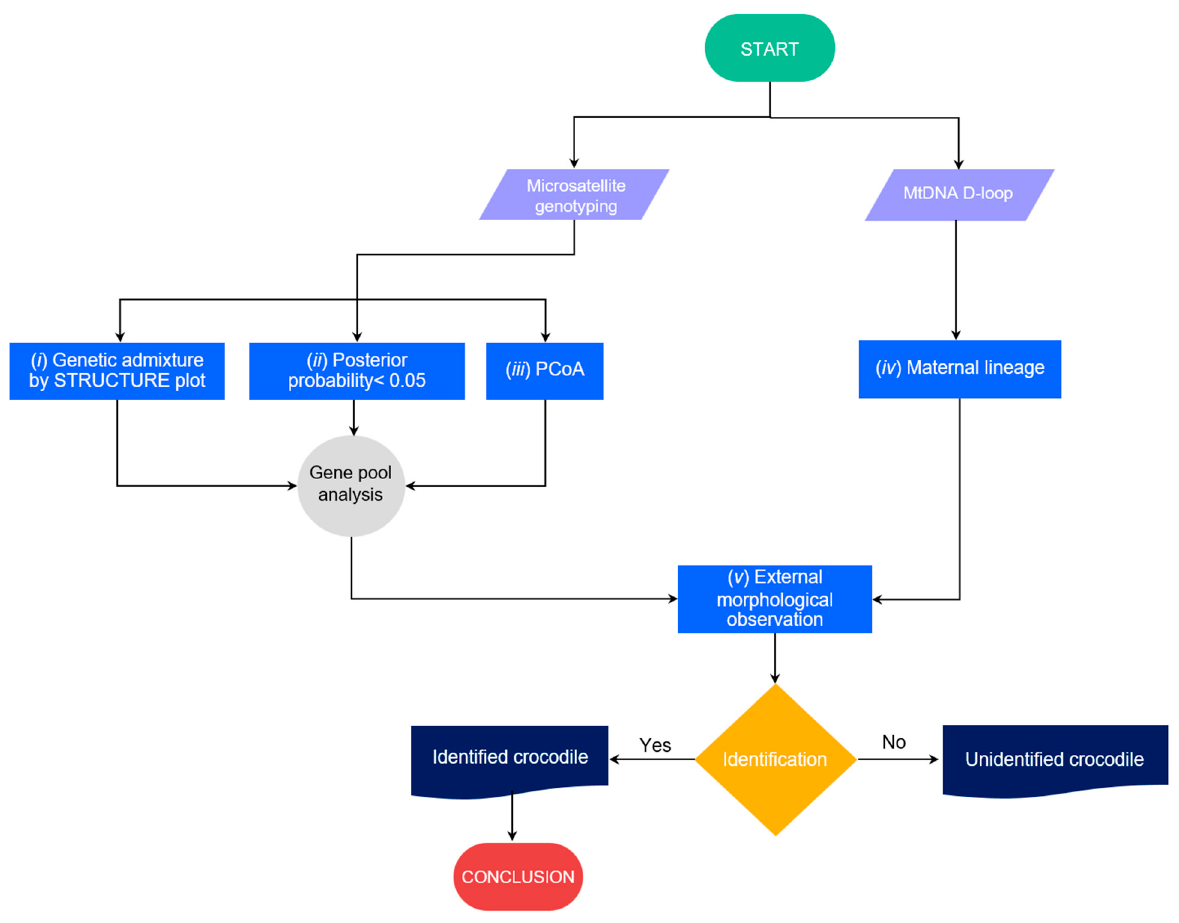
Figure 6. Schematic representation of criteria to screen hybrid crocodiles between Siamese and saltwater crocodiles to prove the hybridization level status in each Siamese crocodile individual before they can be used in the reintroduction program.